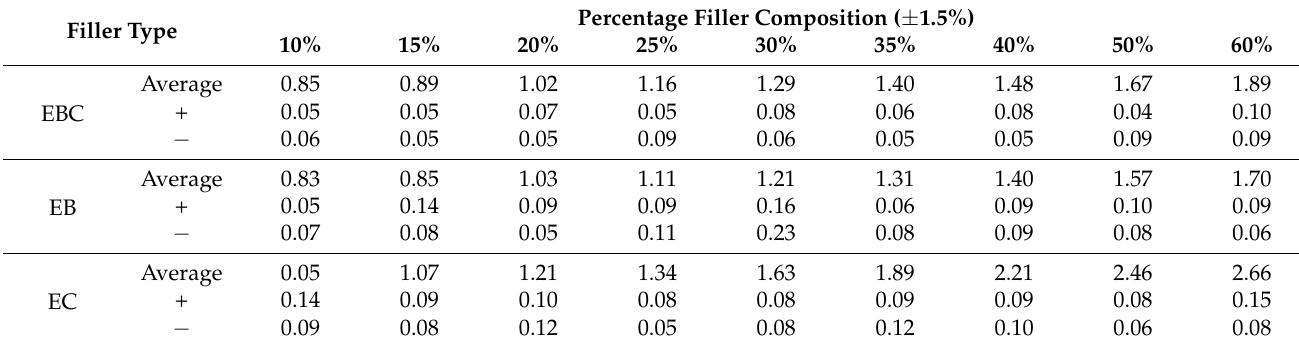
Table 11. Summary of Thermal conductivity values for EBC, EB, and